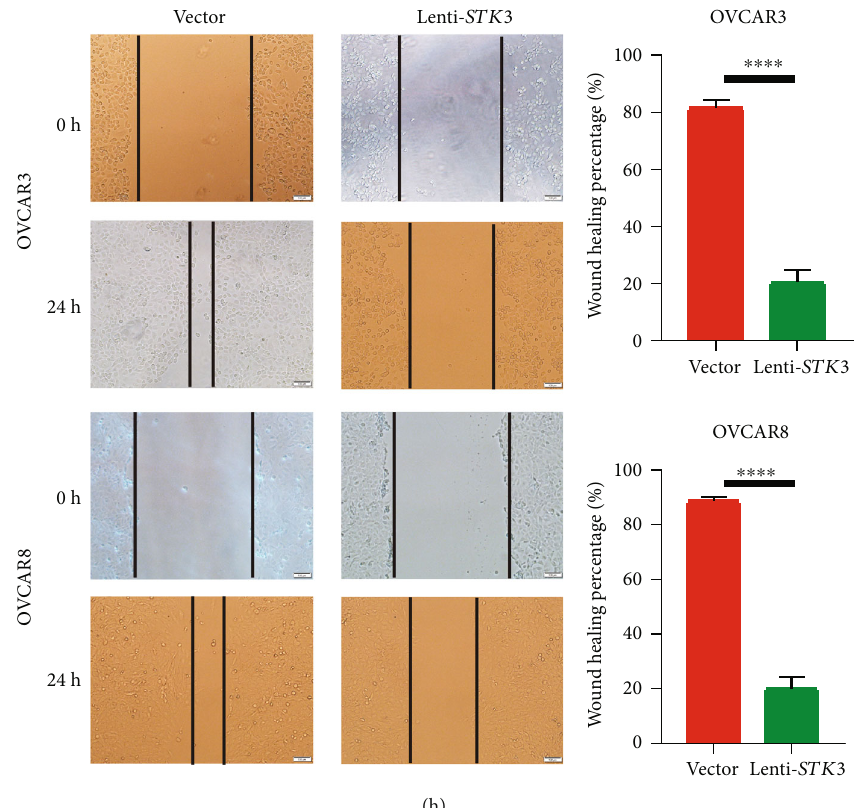
Figure 2: Overexpressed STK3 can inhibit the invasion and proliferation of ovarian cancer cells in vitro and in vivo. (a) The STK3 expression in fi ve di ff erent cell lines measured by qRT-PCR and Western blotting. (b) The STK3 overexpression was con fi rmed by Western blotting and qRT-PCR in OVCAR3 and OVCAR8 cell lines. (c) E ff ect of the STK3 overexpression on the proliferation and colony formation of OVCAR3 and OVCAR8 cells in vitro (two-tailed Student ’ s t -test, ∗ P < 0 : 05 ; ∗∗∗ P < 0 : 001 ). (d) The overexpression of STK3 arrested ovarian cancer cells at G2/M. The cell cycle distribution of OVCAR3 and OVCAR8 cells detected by fl ow cytometry (two- tailed Student ’ s t -test, ∗ P < 0 : 05 ). (e) The overexpression of STK3 promotes ovarian cancer cell apoptosis, as detected by cell apoptosis assays (two- tailed Student ’ s t -test, ∗∗ P < 0 : 01 ; ∗∗∗ P < 0 : 001 ). (f) Morphologic characteristics of tumors from mice inoculated with vector and lenti-STK3/OVCAR8 cells. Tumor weights and volumes of the vector and lenti-STK3 groups are shown (two- tailed Student ’ s t -test, ∗∗ P < 0 : 01 ). The overexpression of STK3 can inhibit the invasion and migration of ovarian cancer cells. (g) E ff ect of the STK3 overexpression on invasion and migration of OVCAR3 and OVCAR8 cells by cell migration and invasion assays (two- tailed Student ’ s t -test, ∗∗∗ P < 0 : 001 ; ∗∗∗∗ P < 0 : 0001 ). Scale bar: 100 μ m. (h) E ff ect of the STK3 overexpression on the migration of OVCAR3 and OVCAR8 cells detected by wound healing assays (two- tailed Student ’ s t -test, ∗∗∗ P < 0 : 001 ; ∗∗∗∗ P < 0 : 0001 ). Scale bar: 100 μ